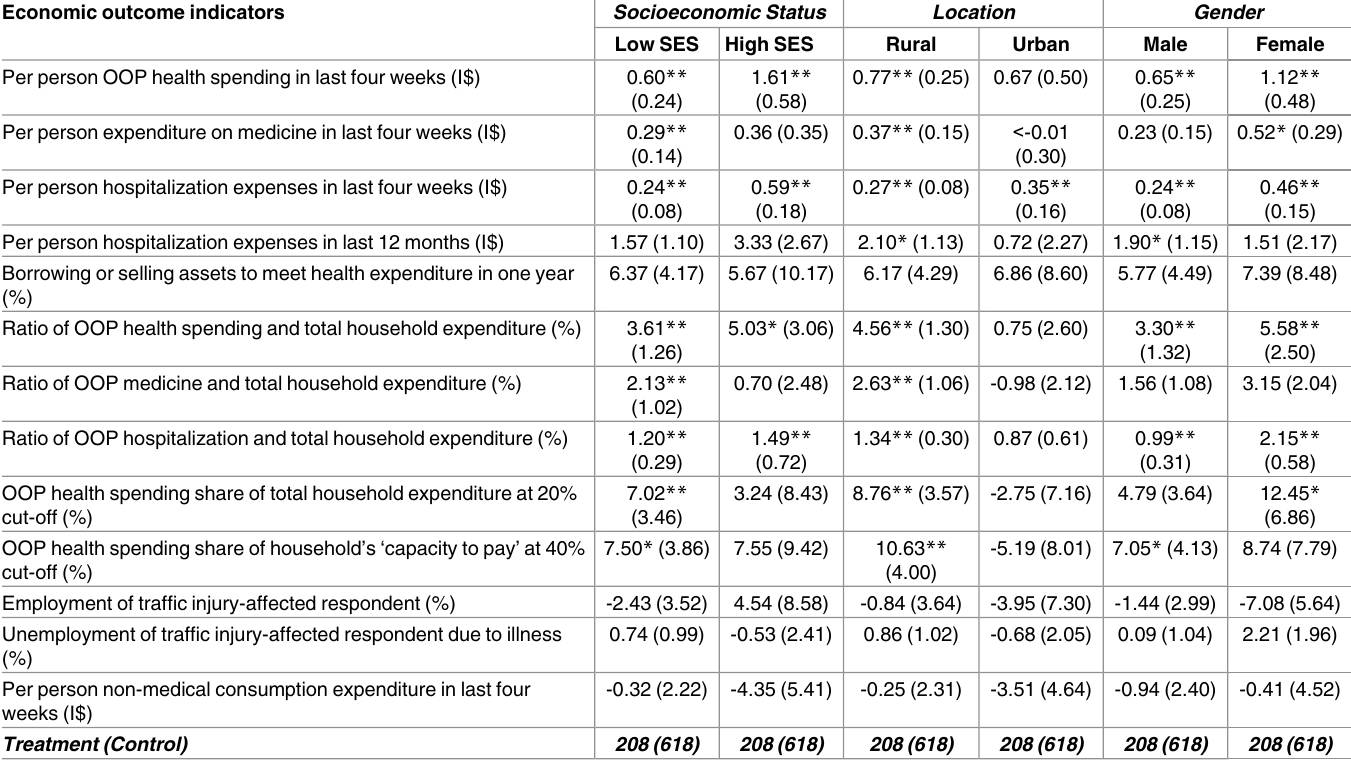
Table 3. Economic Impacts of Road Traffic Injuries on Households, South Asia, 2003: Sub-Group